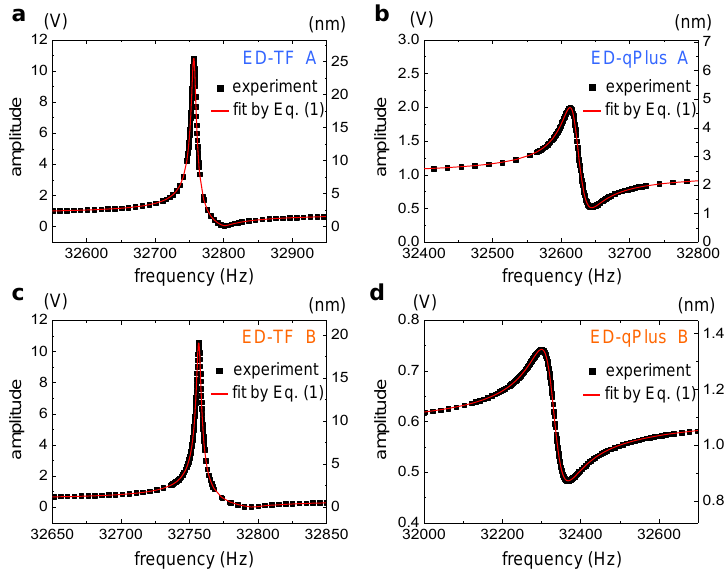
Figure 2. Electrically measured resonance curves of the bare tuning fork and its qPlus configuration (both electrically driven). The electrical signals of the tuning fork ( a , c ) and qPlus ( b , d ) showed asymmetric curves with one peak and one local minimum. These curves were well fit by Equation (1) derived from the equivalent circuit model (Figure 1c). From each fit, we could uniquely determine the dynamic characteristics shown in Equation (1), A 0 , Q , f 0 (= w 0 /2 π ) , and C 0 (= C 0 / C ) , for each probe. We used two tuning forks with different sizes, electrically driven tuning fork (ED-TF) A and ED-TF B ( a , c ), and they were transformed to qPlus sensors, ED-qPlus A and ED-qPlus B ( b , d ), respectively. The electrical signal in volts (left vertical axis) was converted into mechanical amplitude in nanometers (right vertical axis) by using a theoretical method (method (a) described in Ref. [16]). For accurate calibration of oscillation amplitude, one can use experimental methods based on thermal noise spectrum (method (b) in Ref. [16]) for qPlus sensors and energy balance principle [21] generally for quartz resonators, rather than the theoretical